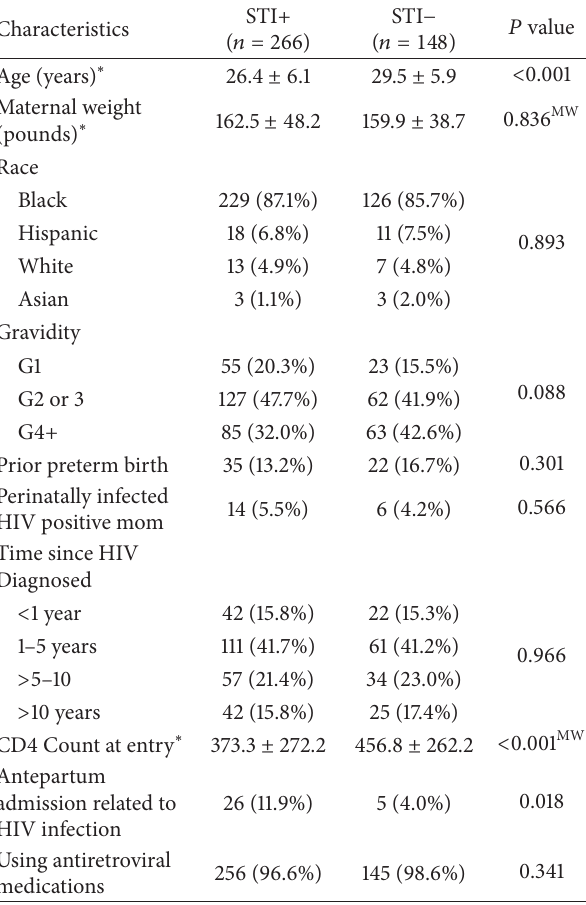
Table 1: Key demographic and clinical characteristics of study population.